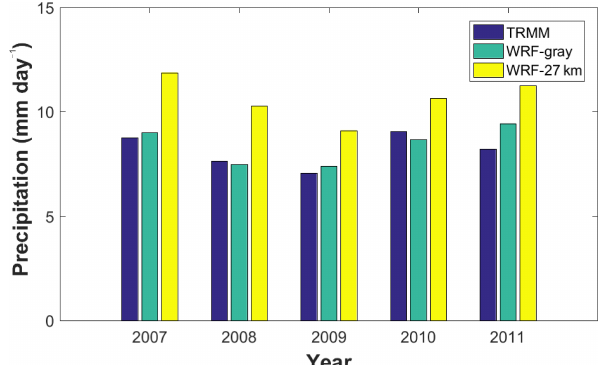
Figure 2. Averaged daily rainfall over the Indian subcontinent for JJAS in different years from TRMM observation (blue bars), WRF- gray (green bars), and WRF-27km (yellow